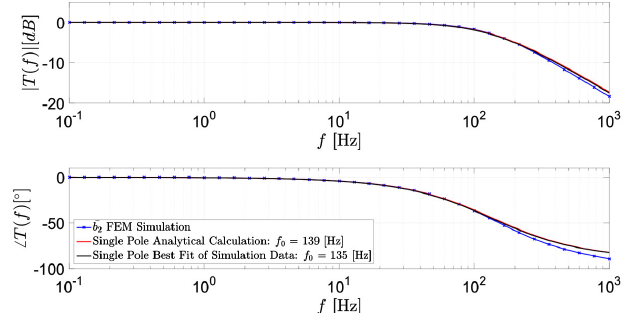
FIG. 17. LHC main quadrupoles at 20 K with position dependent